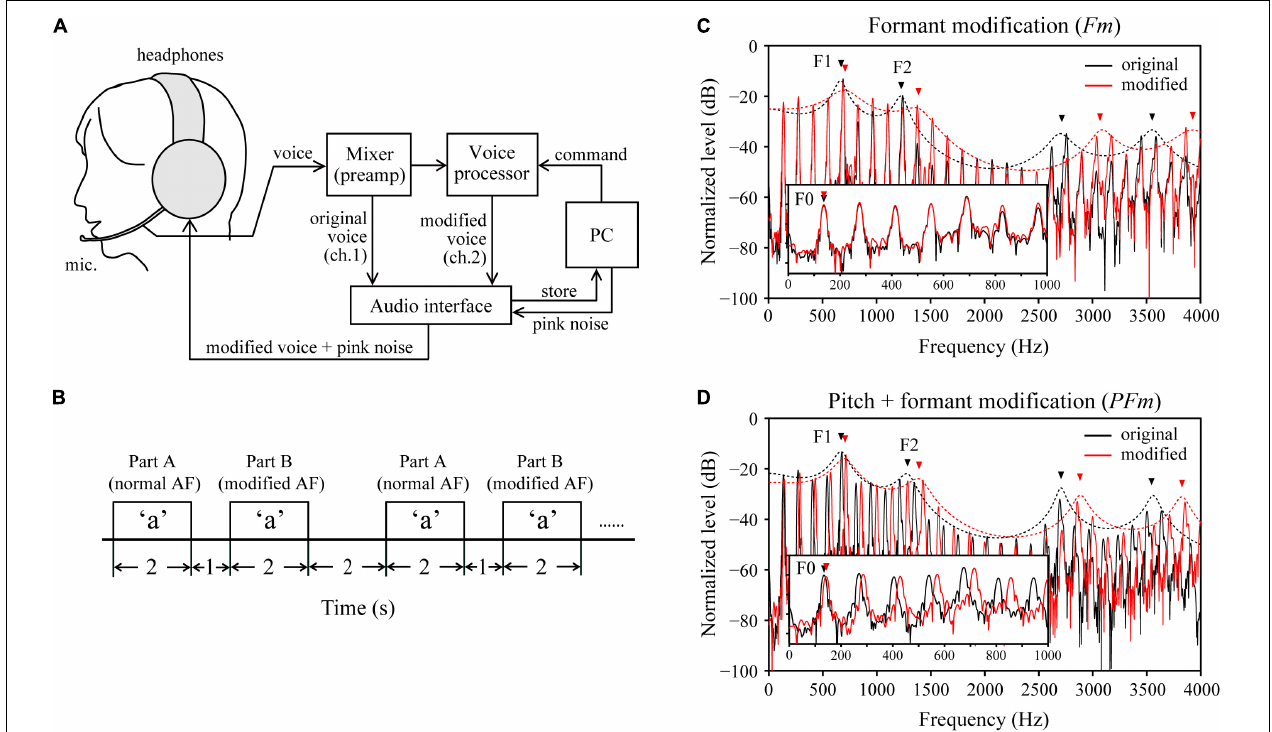
FIGURE 1 | Experimental design. (A) A schematic diagram of the voice-changing system used for real time modifications to the auditory feedback (AF). ch: channel. (B) Schema for the timing of the task design. AF: auditory feedback. Note that for part B, AF was modified from the onset until the end of vocalization. (C) An example of the formant modification (Fm) condition, wherein the formants’ (e.g., the 1st and 2nd formants, F1–F2) frequencies were increased by 200 cents, but the fundamental frequency (F0) was unchanged. (D) An example of the pitch + formant modification (PFm) condition, wherein both the F0 and formants frequencies were increased by 100 cents. In both (C,D) , black and red lines represent the spectra (solid lines) and spectral envelope (dotted lines) of the original voice and modified voice, respectively, obtained from one male participant during the